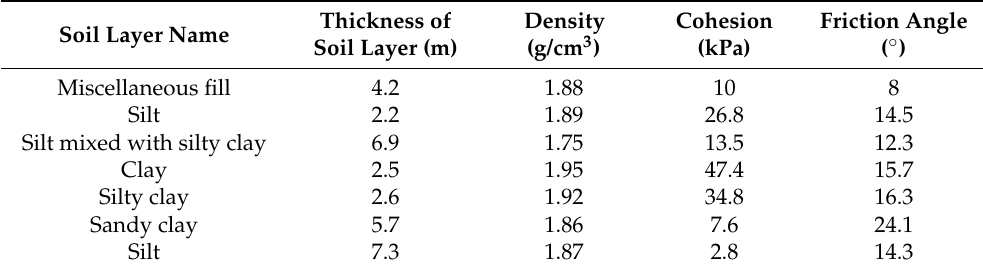
Table 1. Physical and mechanical parameters of the soil layer in the foundation pit.